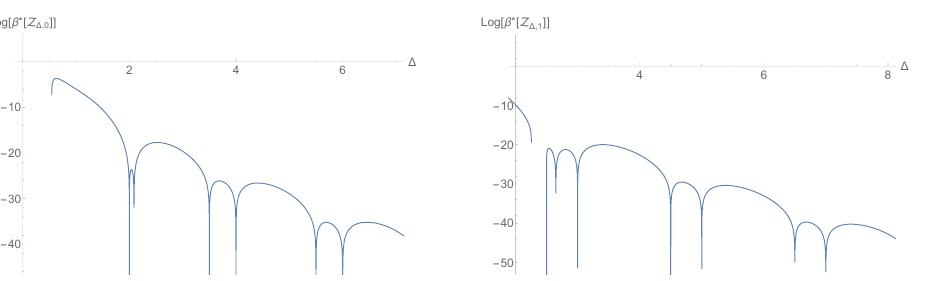
Table 6. The maximum value of degeneracies for low-lying states in a putative CFT with c = 6.